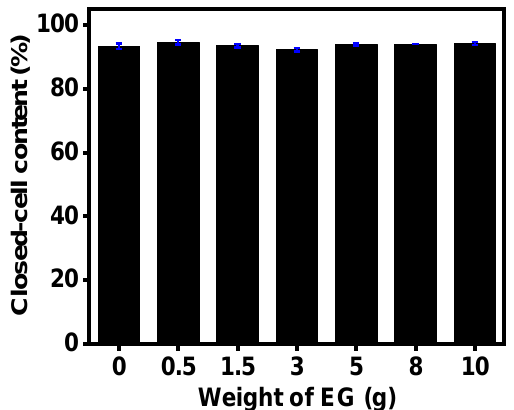
Figure 5. Density of polyurethane foams with carvone-based polyol with an increasing amount of EG.